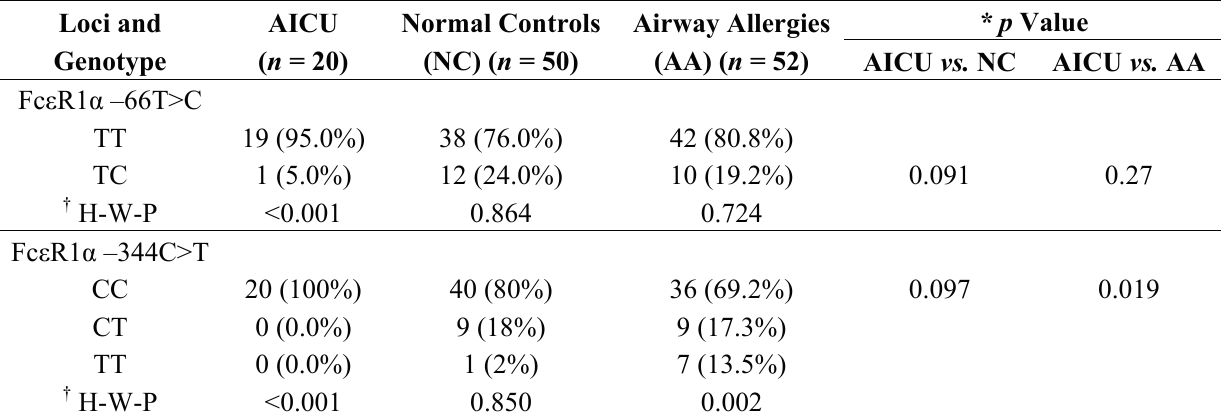
Table 2. The genotype and allele frequency of the promoter gene of Fc ε R1